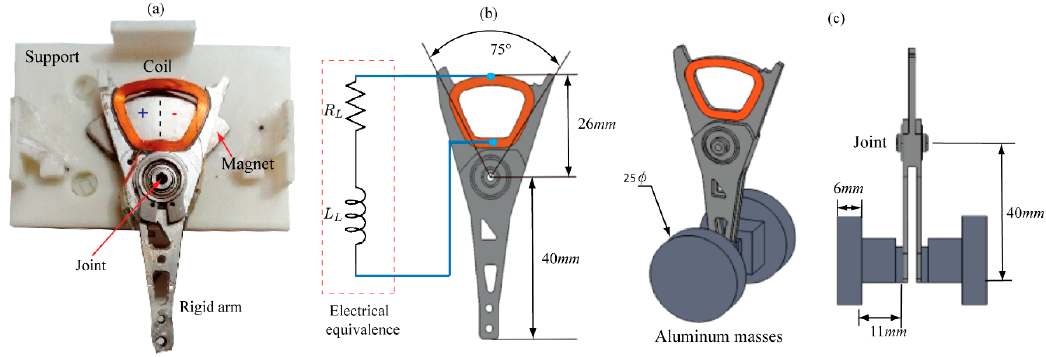
Figure 2. Principal components of the energy harvester. ( a ) Transduction system. ( b ) Inductive electrical scheme. ( c ) 3D model with dimensions in mm.